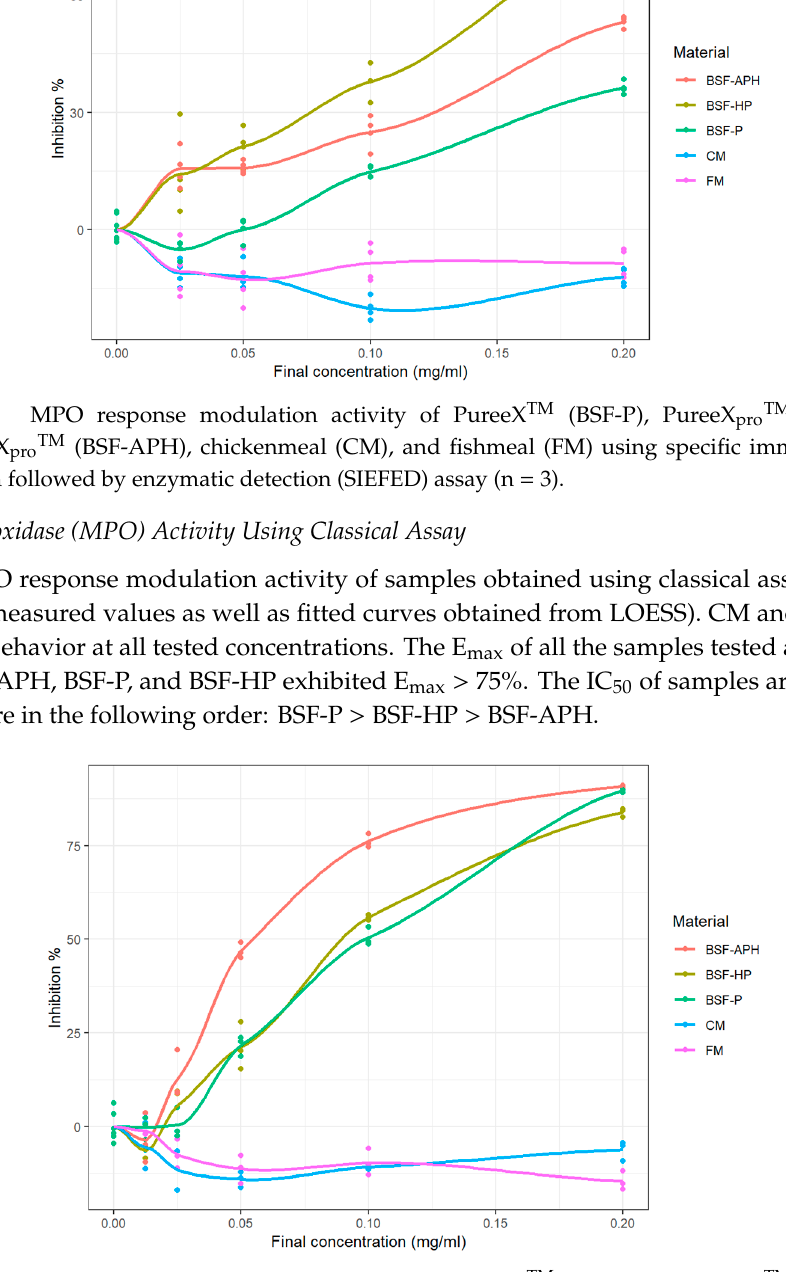
Figure 4. MPO response modulation activity of PureeX TM (BSF-P), PureeX proTM (BSF-HP), ProteinAX proTM (BSF-APH), chickenmeal (CM), and fishmeal (FM) using classical measurement (n=3).